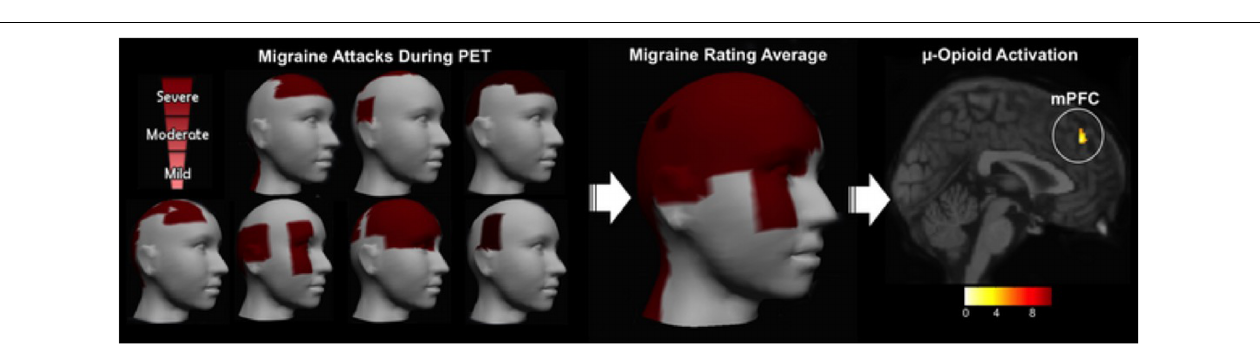
FIGURE 2 | Reduced µ -opioid receptor binding potential ( µ OR BPND) in Trigeminal Neuropathic Pain. Decreased µ OR BPND in the left NAc in axial (A) , sagittal (B) , and coronal (C) planes (T = 3.2) (DosSantos et al., 2012b).